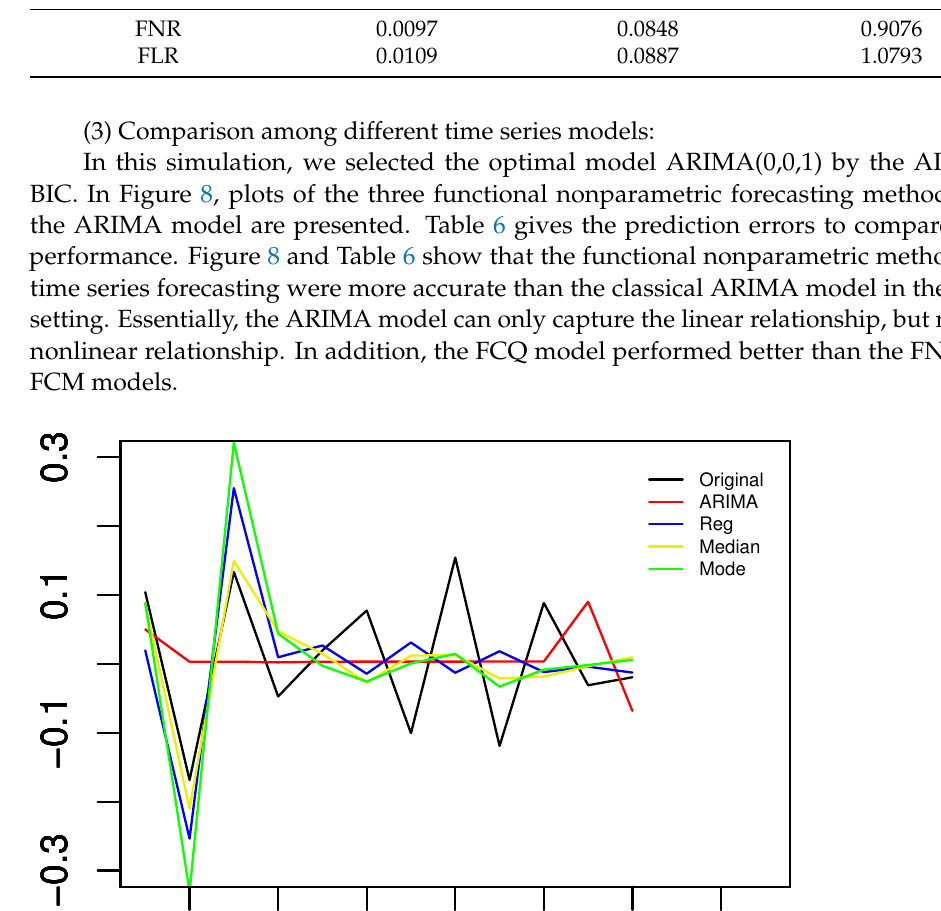
Figure 7. The curves of the true value, FNR model and FLR model. Table 5. The results of forecasting errors for different models. Models